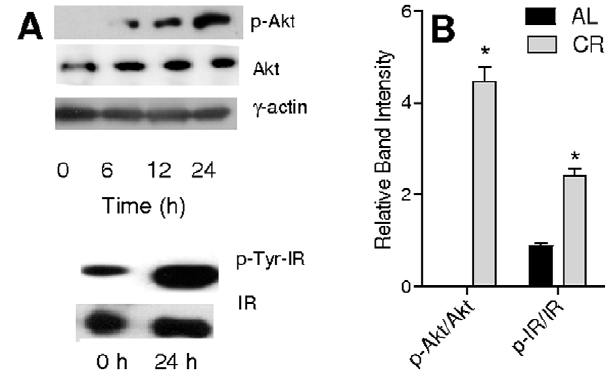
Figure 2. CR serum activates the insulin pathway. ( A ) Upper blots: Akt Ser473 phosphorylation over time after switching from AL to CR serum. Lower blots: Tyr phosphorylation in insulin receptors (IR) immunoprecipitated from VSMC cultured for 24 h in AL or CR media. Representative blots are shown. ( B ) Quantification of pAkt/Akt and p-IR/ IR after 24 h in AL or CR sera. *p , 0.05 versus AL.